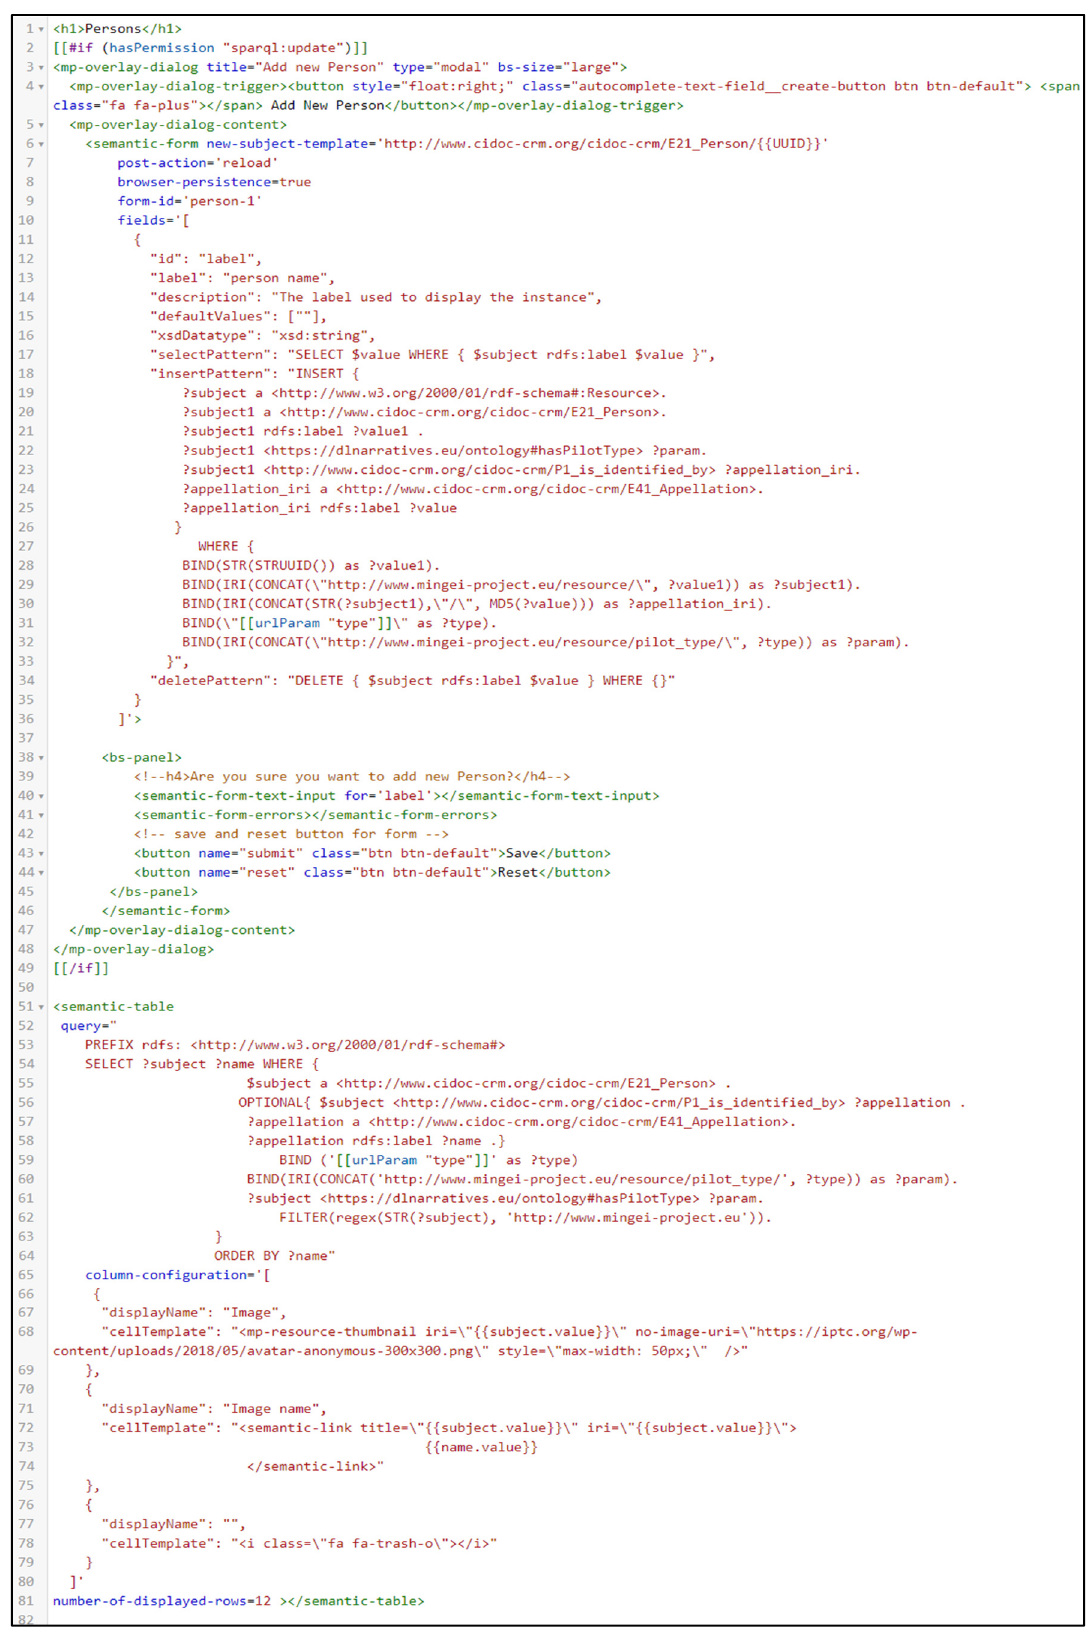
Figure 16. Example code for Table Component